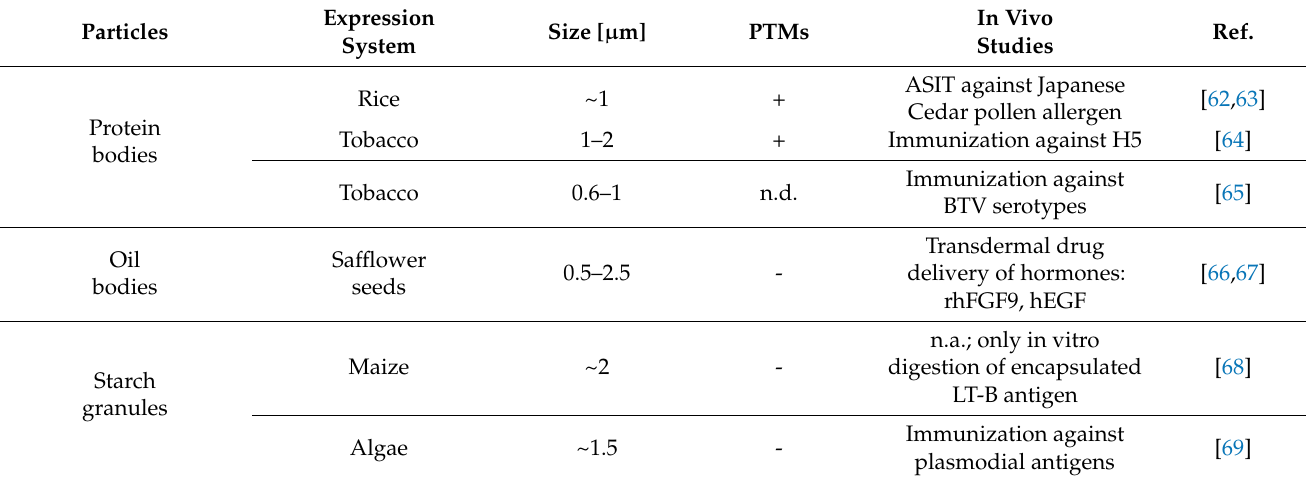
Table 1. Selected examples and comparison of in planta produced